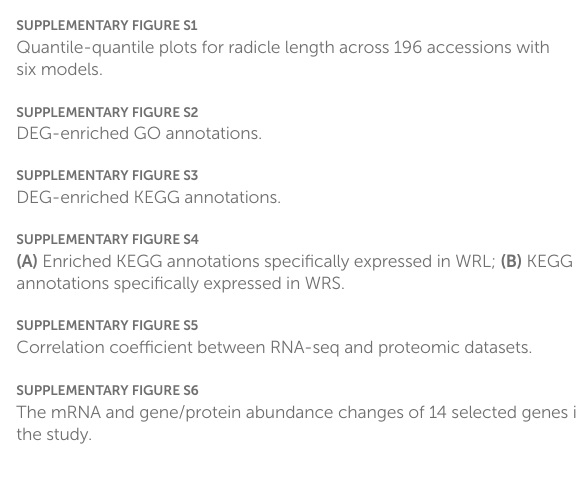
SUPPLEMENTARY FIGURE S2 DEG-enriched GO annotations. SUPPLEMENTARY FIGURE S3 DEG-enriched KEGG annotations. SUPPLEMENTARY FIGURE S4 (A) Enriched KEGG annotations specifically expressed in WRL; (B) KEGG annotations specifically expressed in WRS. SUPPLEMENTARY FIGURE S5 Correlation coefficient between RNA-seq and proteomic datasets. SUPPLEMENTARY FIGURE S6 The mRNA and gene/protein abundance changes of 14 selected genes in the